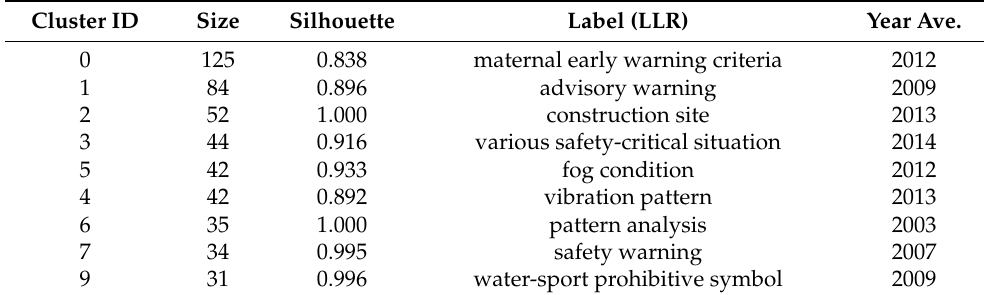
Table 2. Major clusters of co-cited